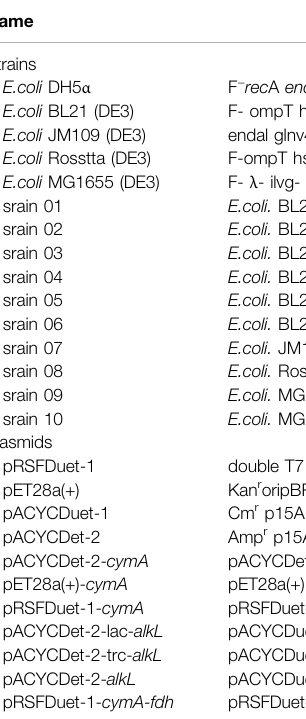
TABLE 1 | Strains and plasmids used in this